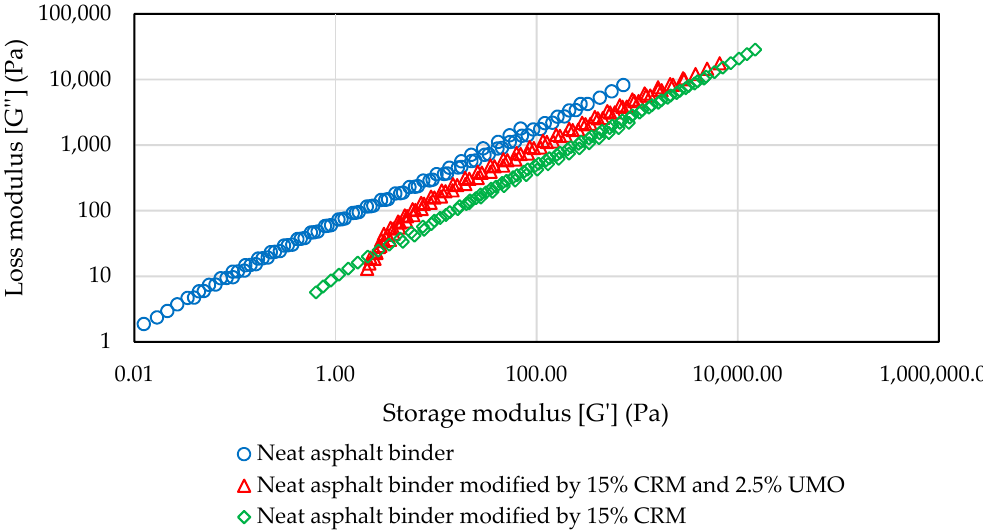
Figure 9. Cole-Cole diagram for PG 52-28 neat and modified asphalt binders interacted at 170 ° C—50 Hz—75 min, measured at a reference temperature 60 °C.